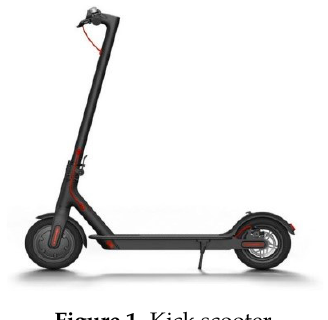
Figure 1. Kick scooter.